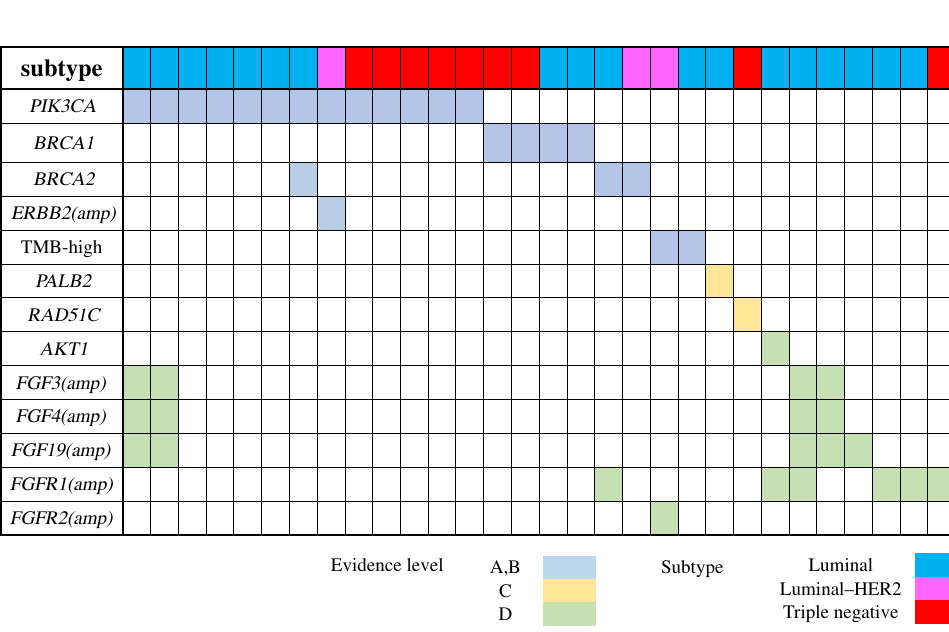
Figure 3. Actionable gene mutations identified in each case. Patients with actionable gene mutations are listed (n =